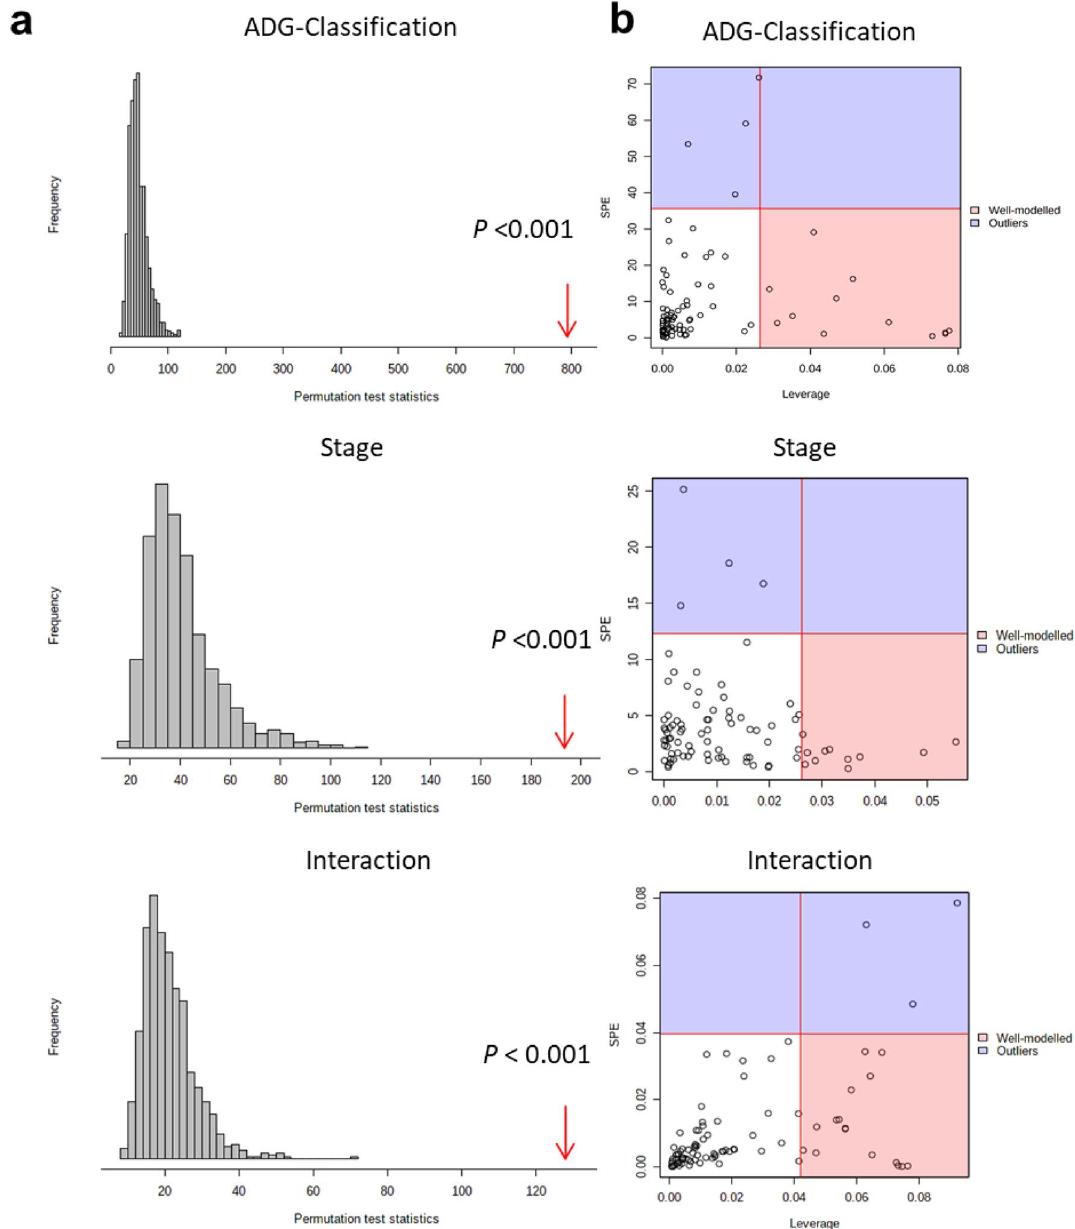
Figure 1. ANOVA-simultaneous component analysis (ASCA) for the ADG-classification, stage, and interaction. ( a ) Model validations through permutations, as demonstrated by significance levels of P < 0.01. ( b ) Leverage/SPE scatter plots of the ASCA variables submodels for ADG-classification, stage and their interactions. Metabolites in red have high loadings that follow the expression patterns of the submodels. Metabolites in blue have expression patterns that are different from the major